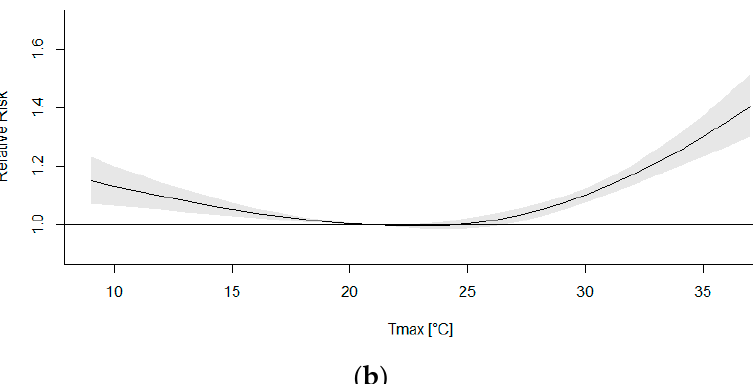
Figure 9. Relation between daily maximum temperature and relative mortality risk (all non-accidental causes) in warm months (June–September) for villages during 2001–2016: ( a ) Wielkopolska; ( b ) Małopolska.